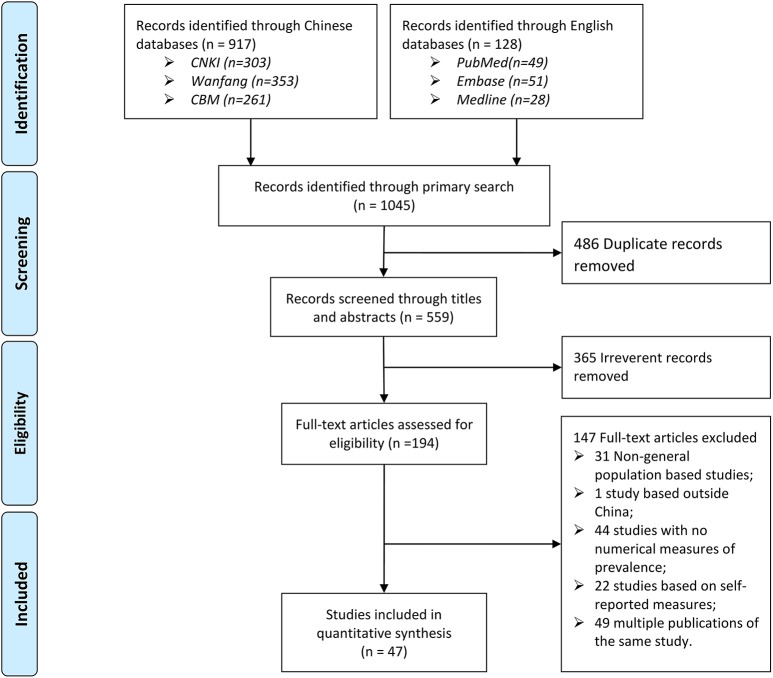
PRISMA flow chart.